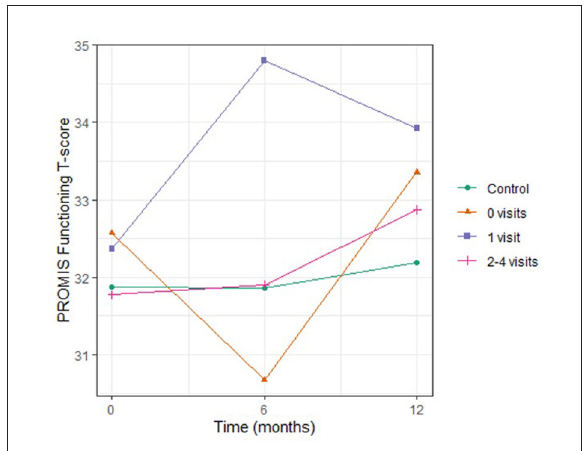
FIGURE3 Social Functioning Levels Over Time in Urban Chicago Households with Young Children, by Number of Community Health Worker Visits. Scores for PROMIS social functioning were plotted over 12 months for study participants. Participants in the control arm did not receive any community health worker (CHW)-led interventions. Amongst participants who were in the intervention arm, PROMIS scores for social functioning did not meaningfully change over time. Stratifying by number of CHW visit received did not yield significant differences in PROMIS social functioning scores between groups nor were there differences in trends over